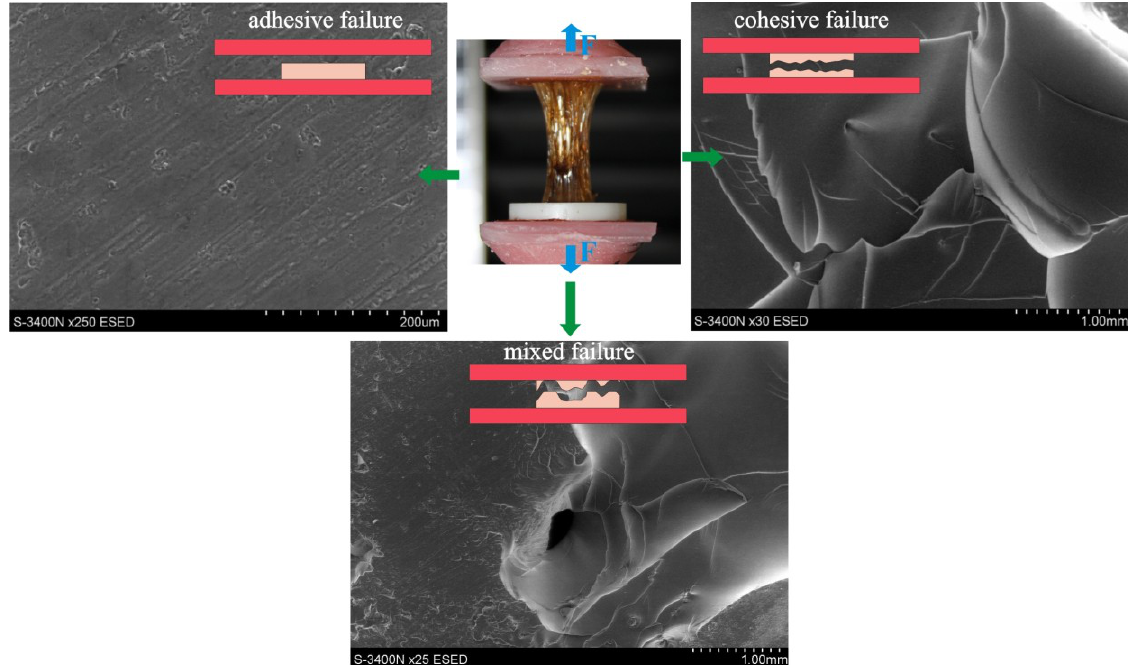
Figure 3. Various types of failures observed during bond strength tensile testing; the SEM images illustrate cohesive, adhesive and mixed (adhesive/cohesive)